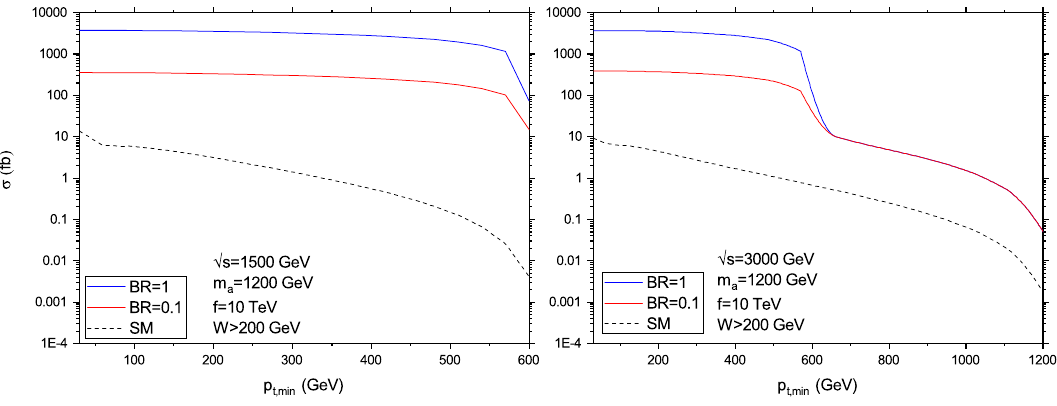
Figure 2 . The differential cross sections for the process γγ photons with the ALP mass m a = 1200 GeV, coupling constant f = 10 TeV, and cut W > 200 GeV imposed on the diphoton invariant mass W . The invariant energy is equal to √ s = 1500 (3000) GeV in the left (right) panel. The curves both for Br( a shown. The dashed lines denote the SM contributions.